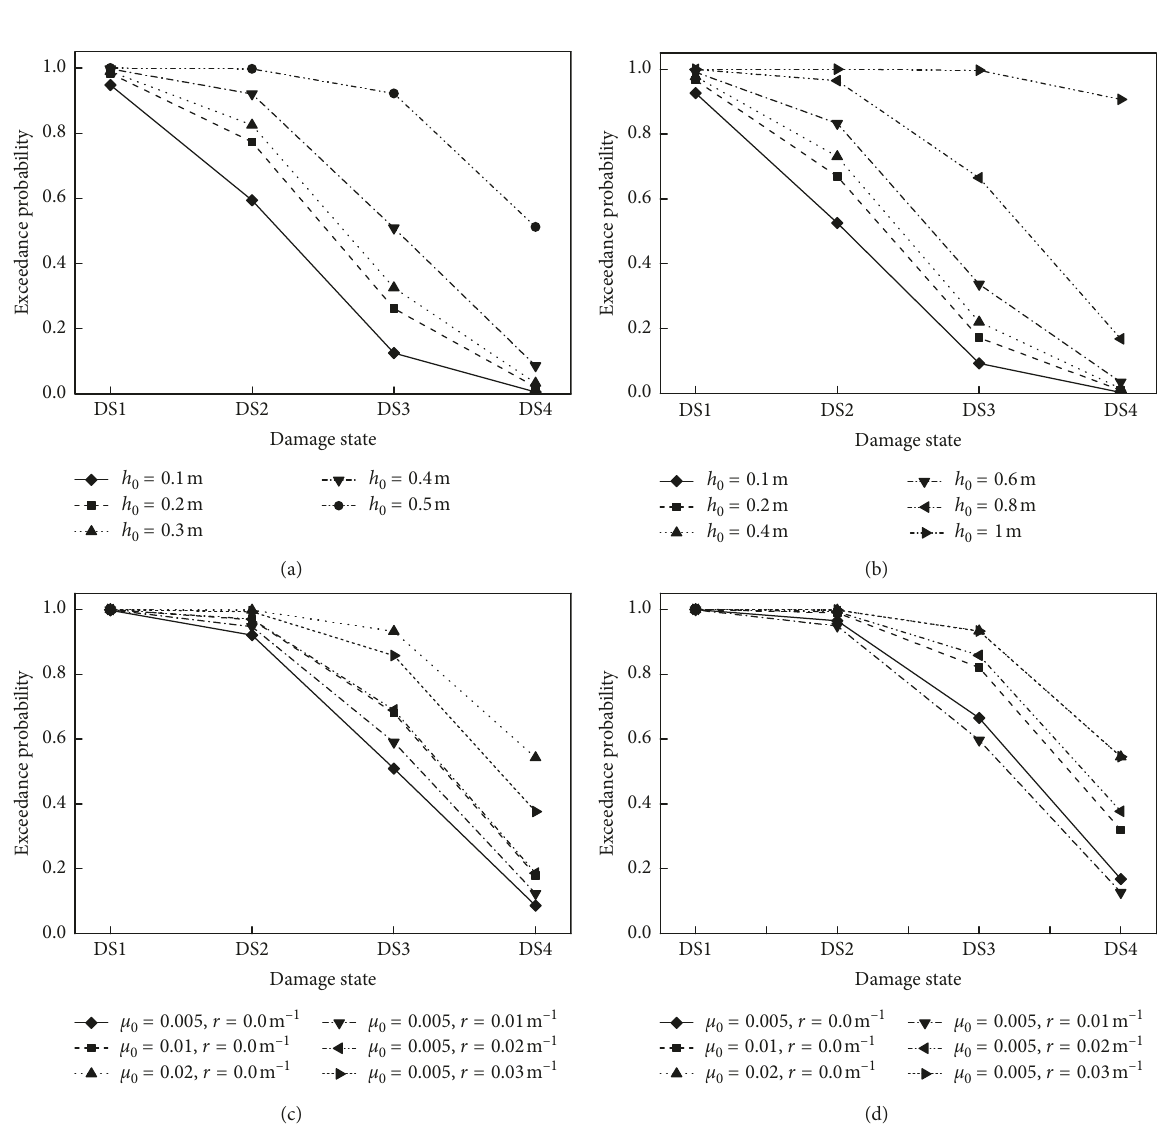
100kN/m, C 0 kN s/m, and PGA 0.8 g (the horizontal ordinates DS1, DS2, DS3, and (cid:31) (cid:31) · (cid:31) 1 , h . 5m. (b) μ 0.005, r 0.0m 1 (cid:31) 0 (cid:31) (cid:31) . 0m, h . − 1 (cid:31) 1 0 (cid:31) 0